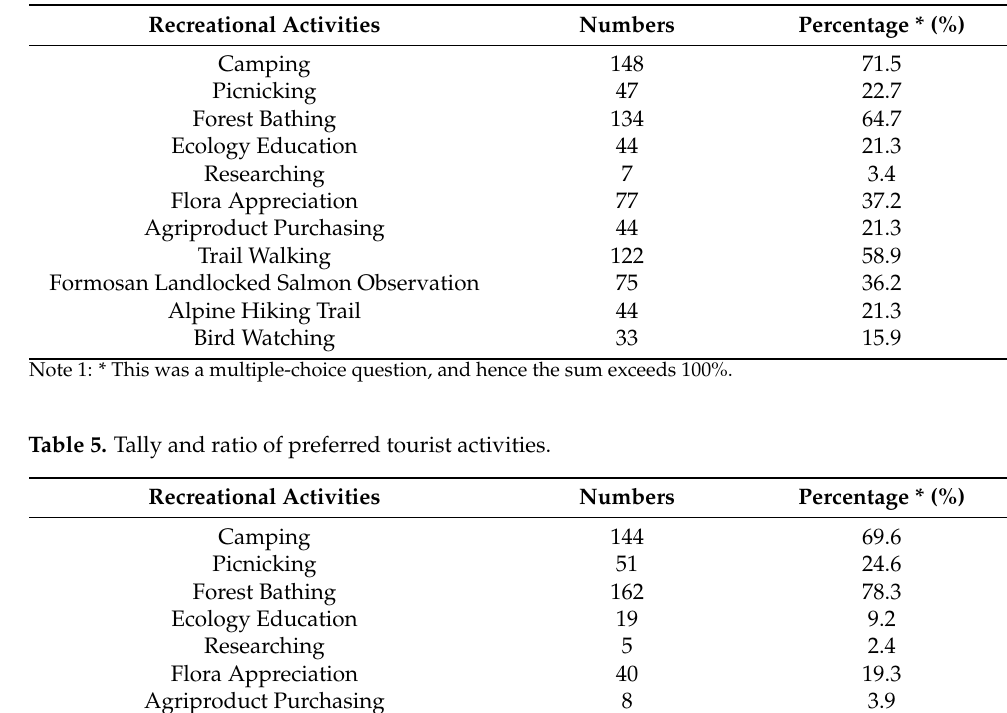
Table 4. Tally and ratio of activities participated in by tourists.